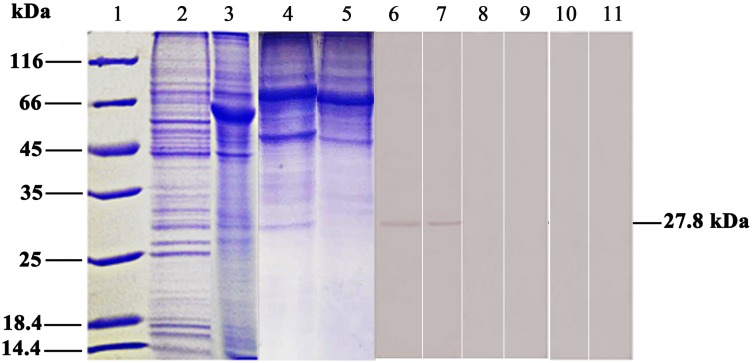
SDS-PAGE and western blotting of the LCDV cellular receptor-27.8kDa protein.Lane 1: Molecular mass marker; Lane 2, 3: SDS-PAGE of FG and HINAE cell membrane protein, stained with coomassie bule; Lane 4, 5: SDS-PAGE of FG and HINAE cell cytoplasm protein, stained with coomassie bule; Lane 6, 7: reaction with anti-27.8R MAbs showed only one 27.8 kDa in FG and HINAE cell membrane protein; Lane 8, 9: reaction with anti-27.8R MAbs showed no band in FG and HINAE cell cytoplasm protein; Lane 10, 11: anti-WSSV MAb 1D5 instead of anti-27.8R MAbs served as negative controls.